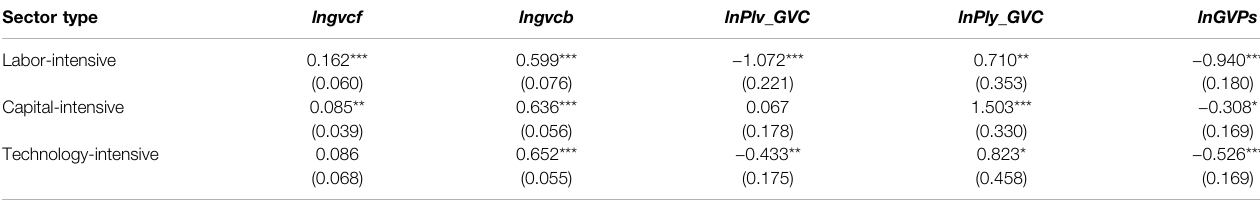
TABLE 6 | Results of heterogeneity analysis for different types of sectors. Sector